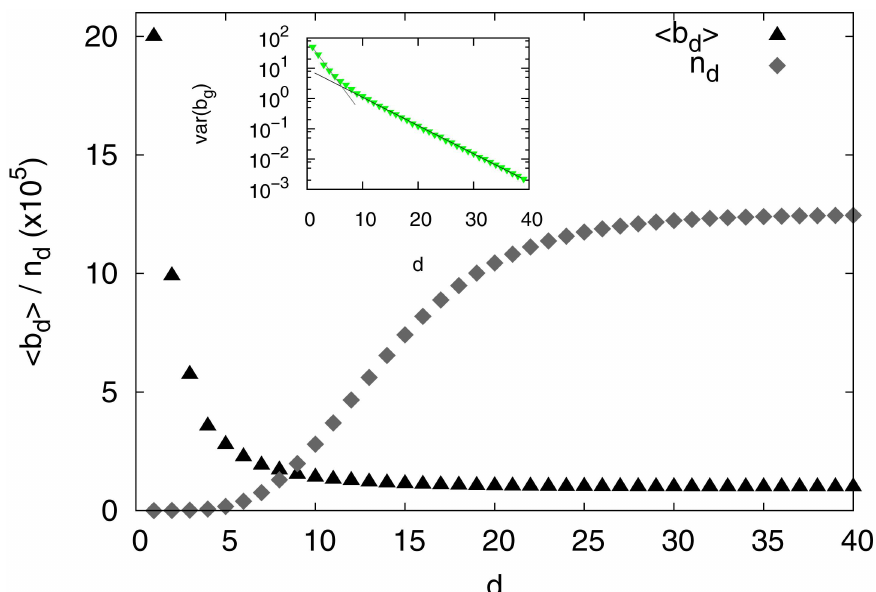
Fig 2. Average branching ratio, h b d i and number of different game-lines n d as function of the depth level d in the database. Inset: variance of the distributionof branches per node b g as function of the depth d and linear fit of the two exponential